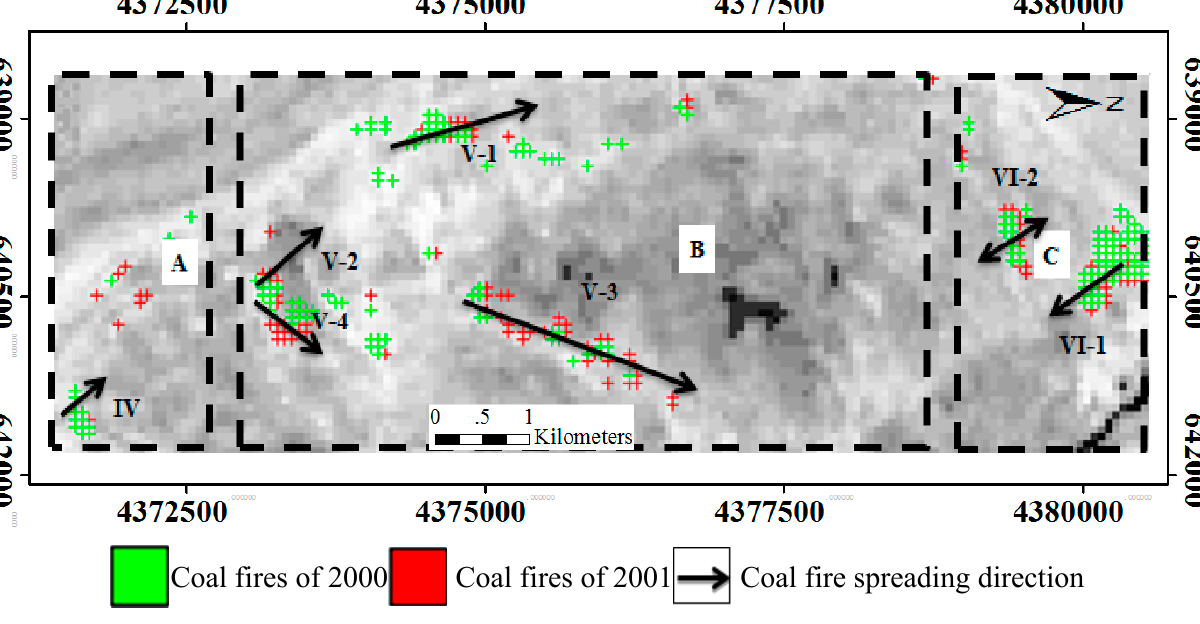
Figure 11. Coal fire map from 2000 to 2001. The results of the coal fires of 2000 and 2001 were stacked for the overlay analysis, and the coal fire spreading directions were also delineated as shown in this